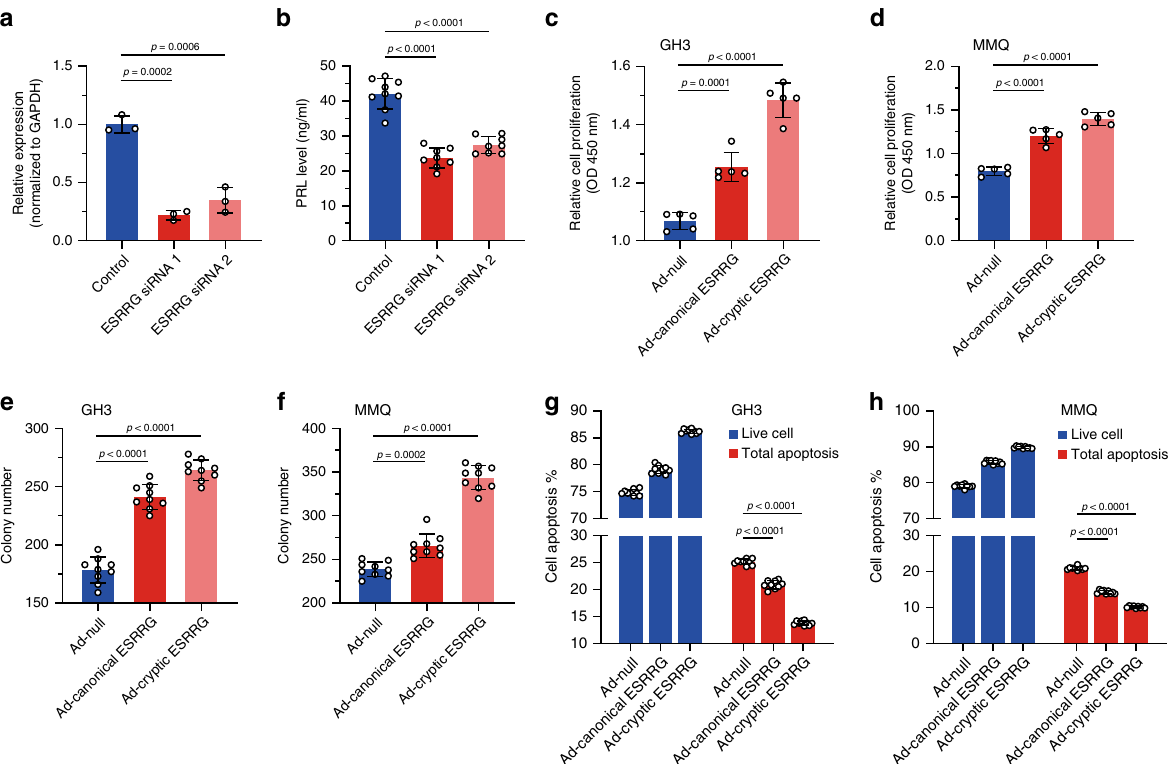
Fig. 6 Downstream effects on aberrant splicing on ESRRG. a The qRT-PCR results display ESRRG mRNA expression levels in primary human prolactinoma cells transfected with control or speci fi c ESRRG siRNA. GAPDH was used as an internal control ( n = 3 per group). b Suppression of PRL secretion